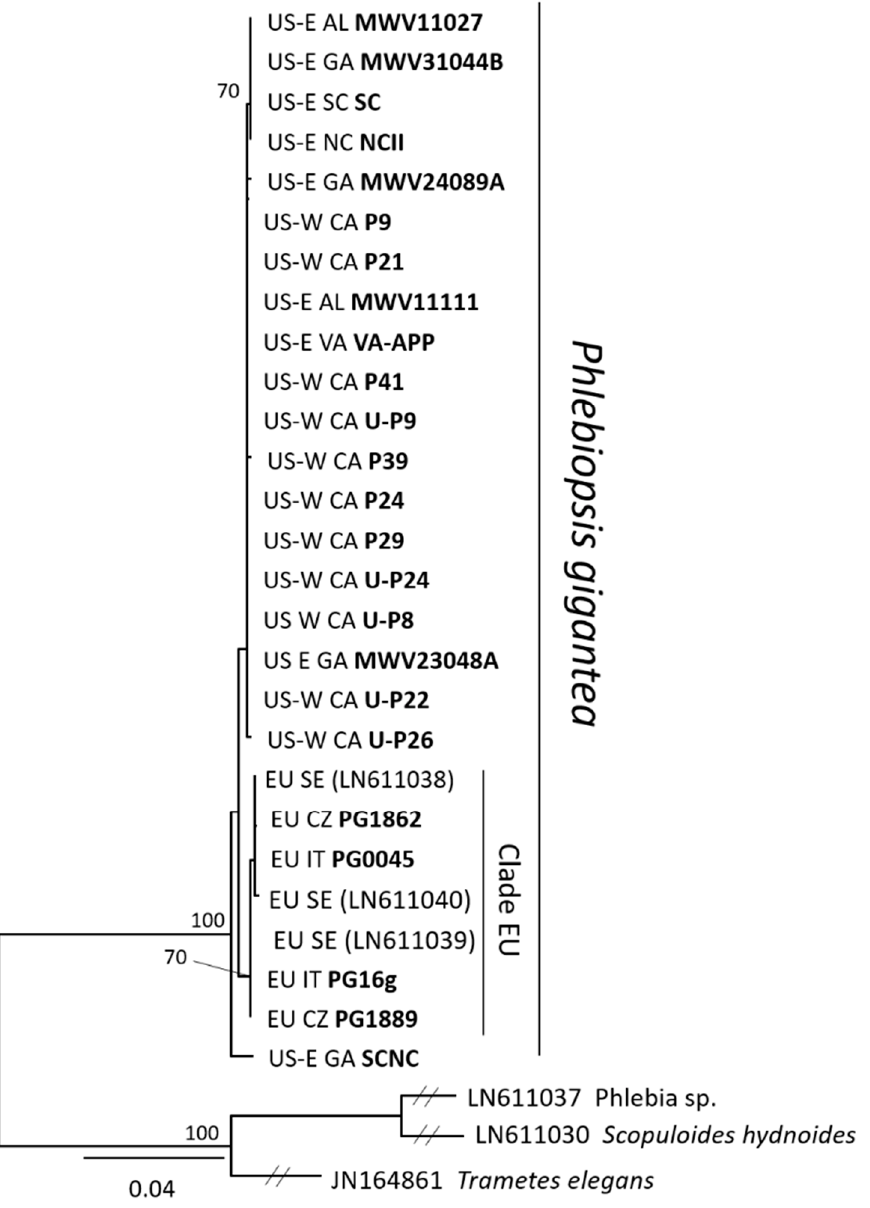
Figure 6. Maximum likelihood phylogram obtained from the RPB2 sequence alignment of Phlebiopsis gigantea . Phlebia sp ., Scopuloides hydnoides and Trametes elegans were used as outgroup taxa. ML bootstrap percentages ≥ 70% are given above each clade. Labels indicate: geographic area, state, isolate code (in bold for sequences newly generated) and GenBank code brackets for sequences retrieved from